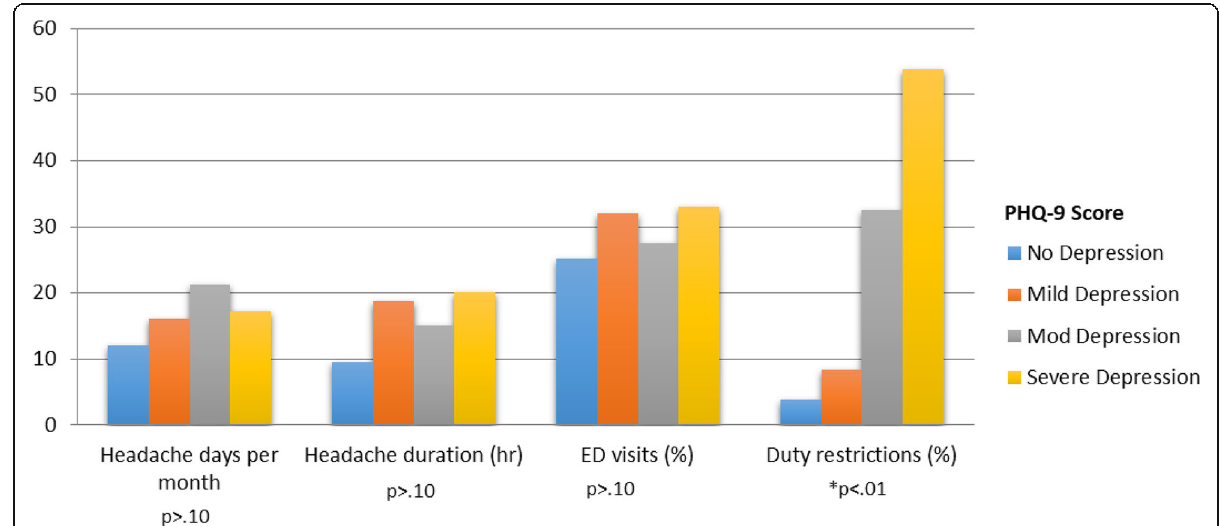
Fig. 2 Headache characteristics based on depression severity. Headache characteristics and duty restrictions were stratified based on the presence and severity of depression, as detected by PHQ-9 scores. No headache characteristics had statistically significant correlation with depression severity. Only duty restrictions were significantly associated with severity of depression based on